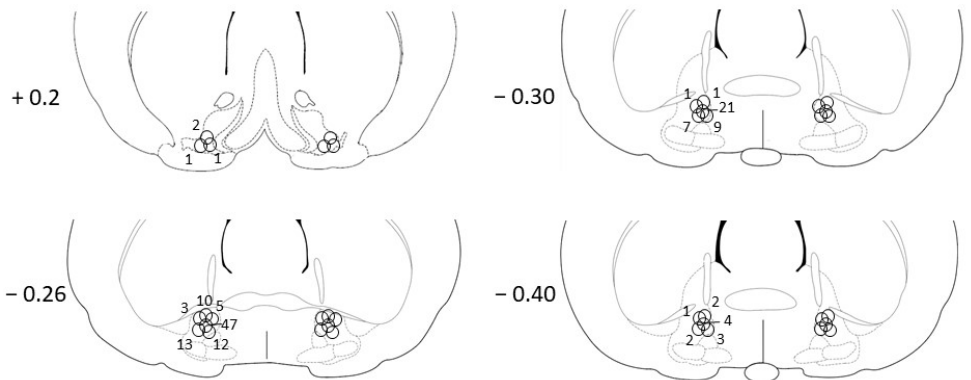
Figure 1. Illustration of correct bilateral injection placements of the injector tips ( n = 145). The num- bers on the left side of the coronal brain sections refer to anterior–posterior distance from the bregma in mm. The borders of VP are presented based on the stereotaxic rat brain atlas of Paxinos and Watson [38]. The circular symbols indicate the centre of the bilateral injection sites. Numbers next to the symbols indicate the number of animals with similar cannula positions.